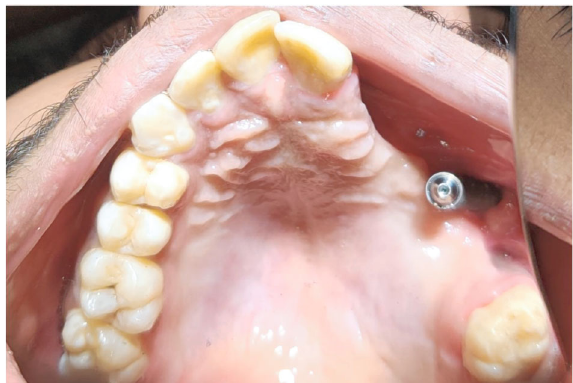
Figure 4: Intraoral view after 5 weeks of healing